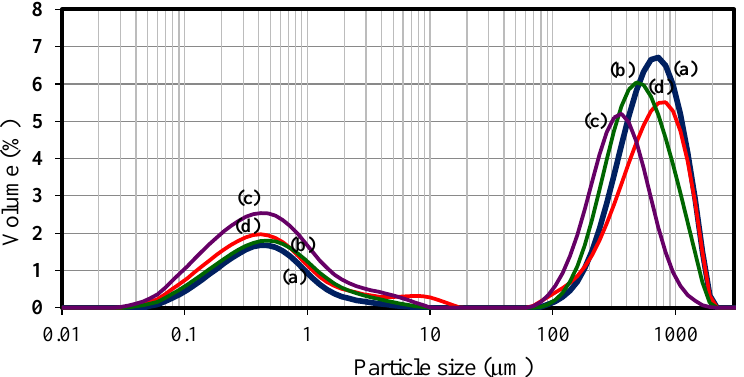
Figure 7. Influence of enzyme concentration and inlet temperature (T inlet) on the particle size distribution of Flavourzyme ® chitosan − TPP microcapsules: (a) 0.04% ( v / v ), T inlet = 130 °C; (b) 0.10% ( v / v ), T inlet = 130 °C; (c) 0.16% ( v / v ), T inlet = 130 °C; (d) 0.10% ( v / v ), T inlet = 160 °C.